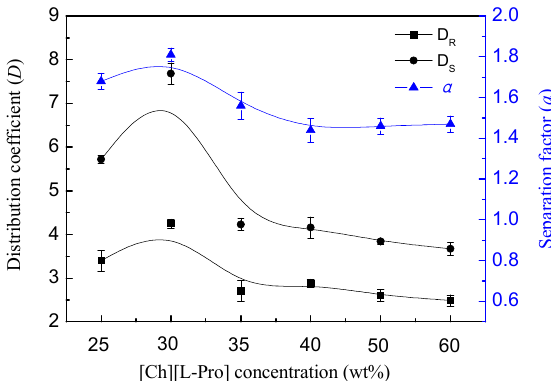
Figure 3. Effect of [Ch][L-Pro] concentration to the chiral extraction of phenylalanine enantiomers. The extraction conditions: 15.6 wt% K 3 PO 4 , 40 mmol/L HP- β -CD, 15 mg/mL phenylalanine. The extraction experiments were performed at room temperature and without adjusting the system pH.